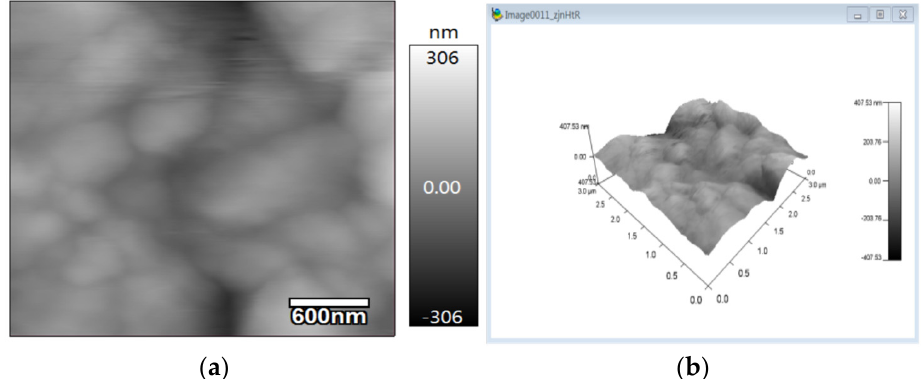
Figure 7. Atomic force microscopy micrographs. ( a ) Two-dimensional surface morphology of rGO- SDS composite film. ( b ) 3D surface roughness of rGO-SDS composite film.